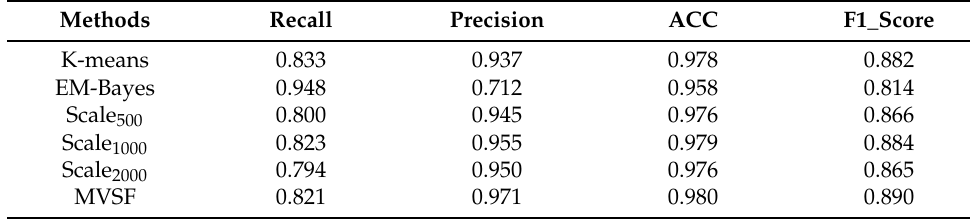
Table 3. Quantitative evaluation of CD results by different methods for Mexico